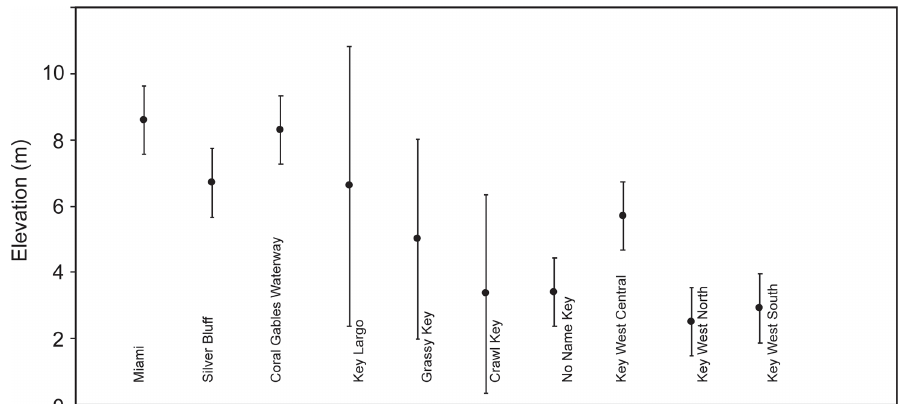
Figure 4. Relative sea-level position during MIS 5e along the east coast of Florida, with sites plotted by decreasing latitude (north to south) from left to right across the diagram. Uncertainties represented by error bars include the combined uncertainty of the elevation measurement and indicative range of the sea-level indicator by adding the uncertainties in